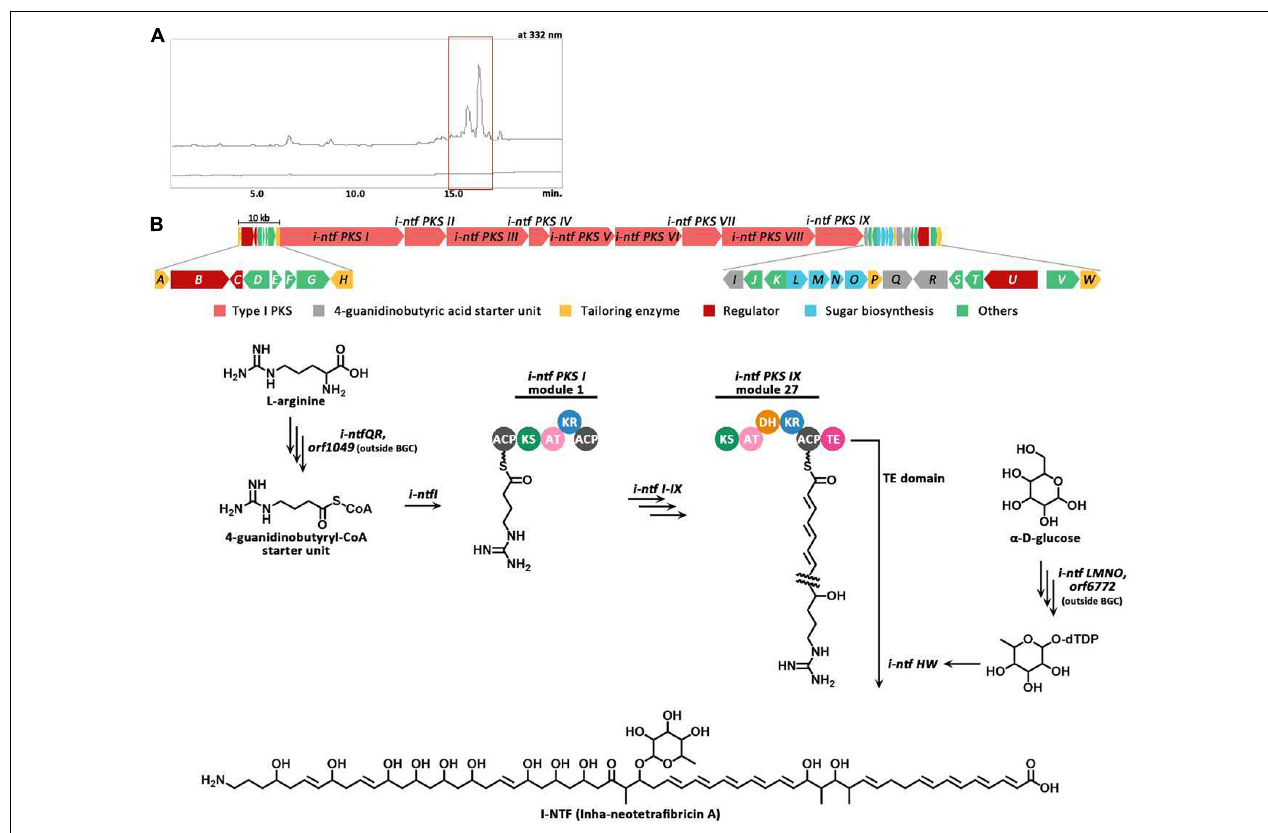
FIGURE 5 | (A) HPLC chromatograms of the cultures from the wild-type S. rubrisoli Inha501 (upper line) and the i-ntf PKS I disrupted S. rubrisoli Inha501 mutant (lower line). The asterisked peak is confirmed to be the I-NTF and the small peak in front of I-NTF peak is believed to the derivative or degradation product of I-NTF (B) ORFs encoded in the putative I-NTF biosynthetic gene cluster and proposed biosynthetic pathway to I-NTF (more details of ORFs are listed in Table 2 ).